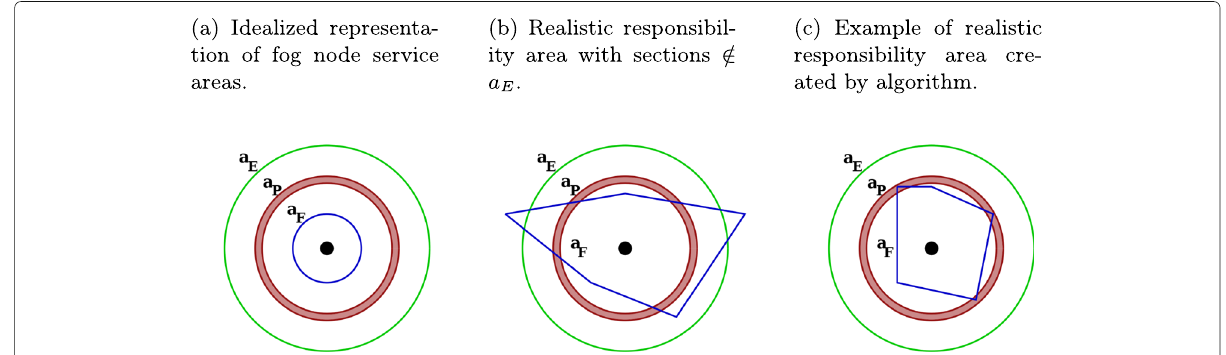
Fig. 3 Graphic representation of idealized and realistic fog node service areas